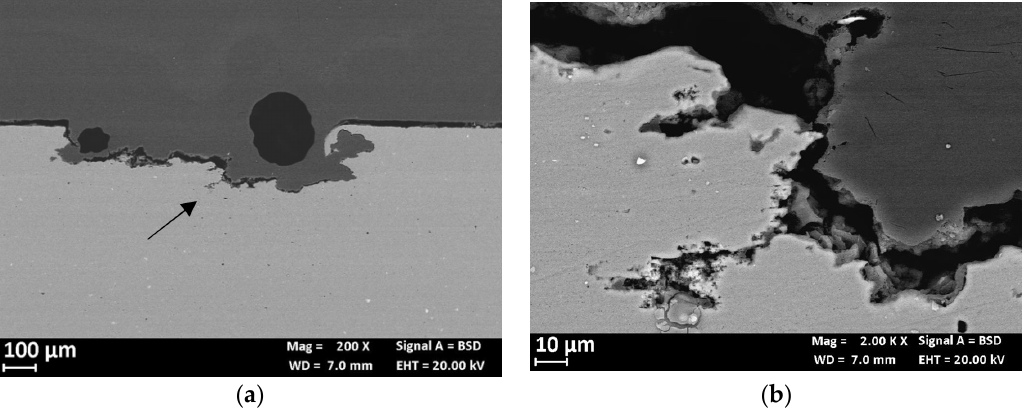
Figure 12. ( a ) Metallographic section of the enlarged localized attack in the TMAZ zone of the CL specimen. Close ‐ up of the arrow in ( b ) in which is evident the change the morphology of attack that allow the rolling direction.